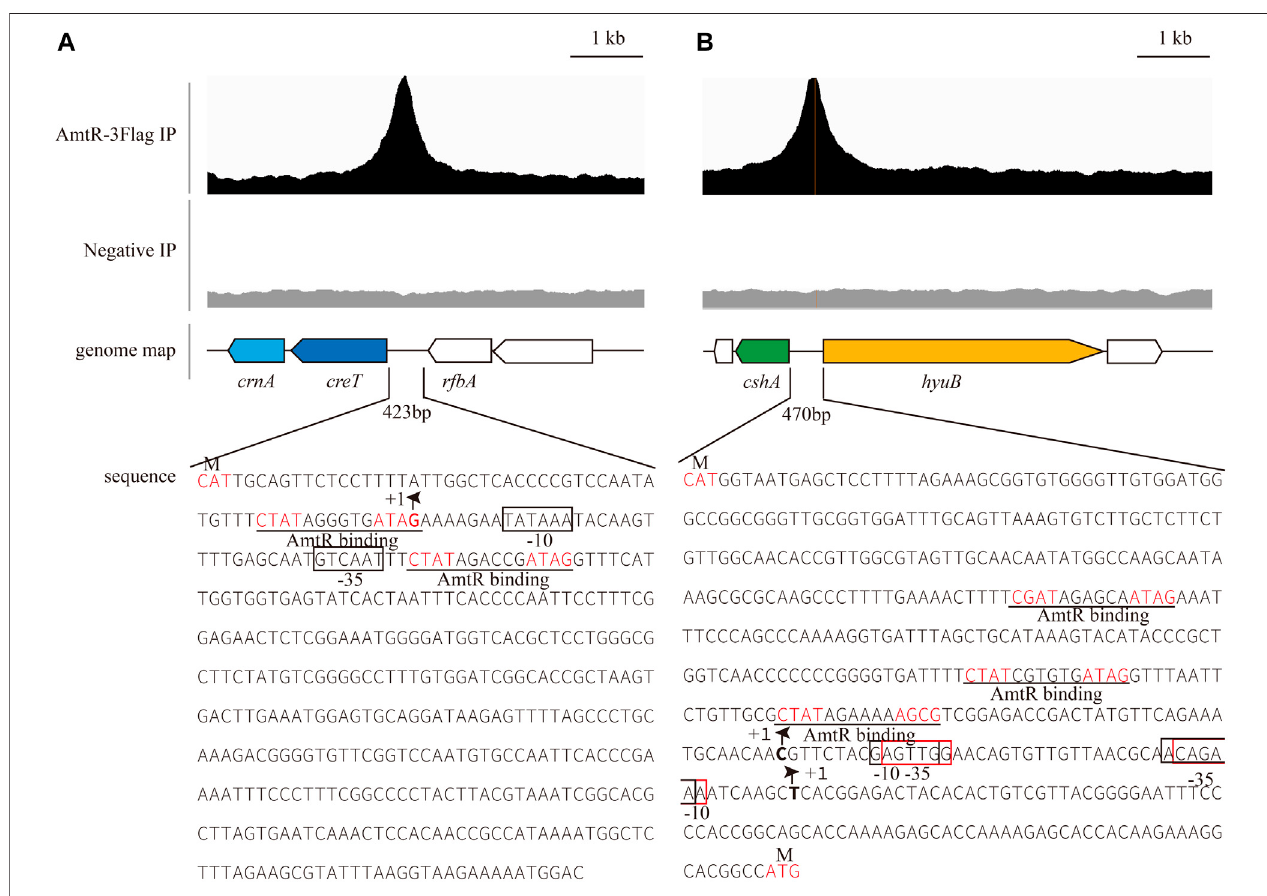
FIGURE2| AmtRChIP-seqpeaksofselectedgenes.Theputativepalindromesequenceisshowninred;theAmtRbindingsequencesarepredictedbyMEMEand underlined. +1indicates thetranscription startsite (TSS), and putative -35,-10 elements and TSSsin thepromotersof cre T- crn A, csh A, and hyu B werepredictedusing the online website (http://www.fruit fl y.org/seq_tools/promoter.html) (Reese, 2001). (A) Putative -35 and -10 elements in the promoter of cre T- crn A enclosed by black rectangles. (B) Putative-35and-10elementsinthepromoterof csh Aenclosedbyblackrectangles,-35and-10elementsinthepromoterof hyu Benclosedbyred